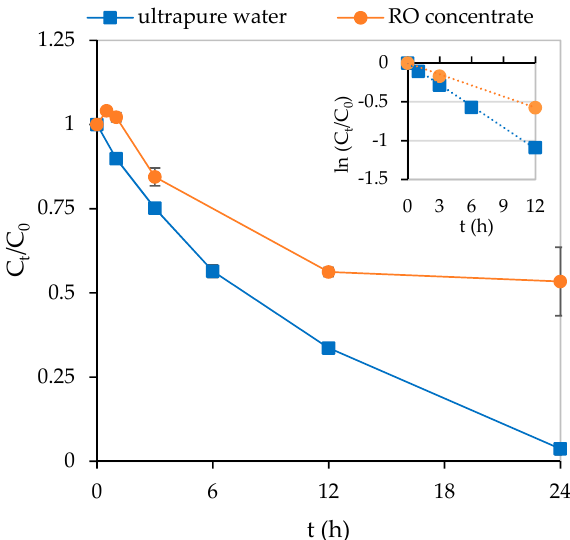
Figure 3. Photocatalytic degradation of crotamiton using the F9/P25 composite sheet with ultraviolet irradiation ( C 0 = 10 mg/L). The inset shows the fitting results of the first-order kinetic model. Results are means ± standard deviations ( n = 2).